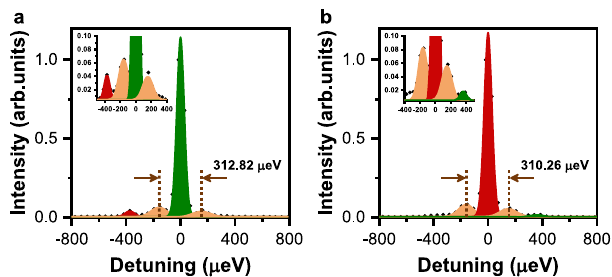
Fig. 4 Size-quantized acoustic phonons in a single CsPbI 3 NC. a Resonantly-excited higher-energy peak (green), the associated side peaks from size-quantized acoustic photons (orange), and the down-converted lower-energy peak (red). Inset: Ampli fi ed view of the low-signal region. See Supplementary Fig. 7 and related discussions in the Supplementary Information for theoretical fi t of this resonantly-excited PL spectrum. b Resonantly-excited lower-energy peak (red), the associated side peaks from size-quantized acoustic photons (orange), and the up-converted higher-energy peak (green). Inset: Ampli fi ed view of the